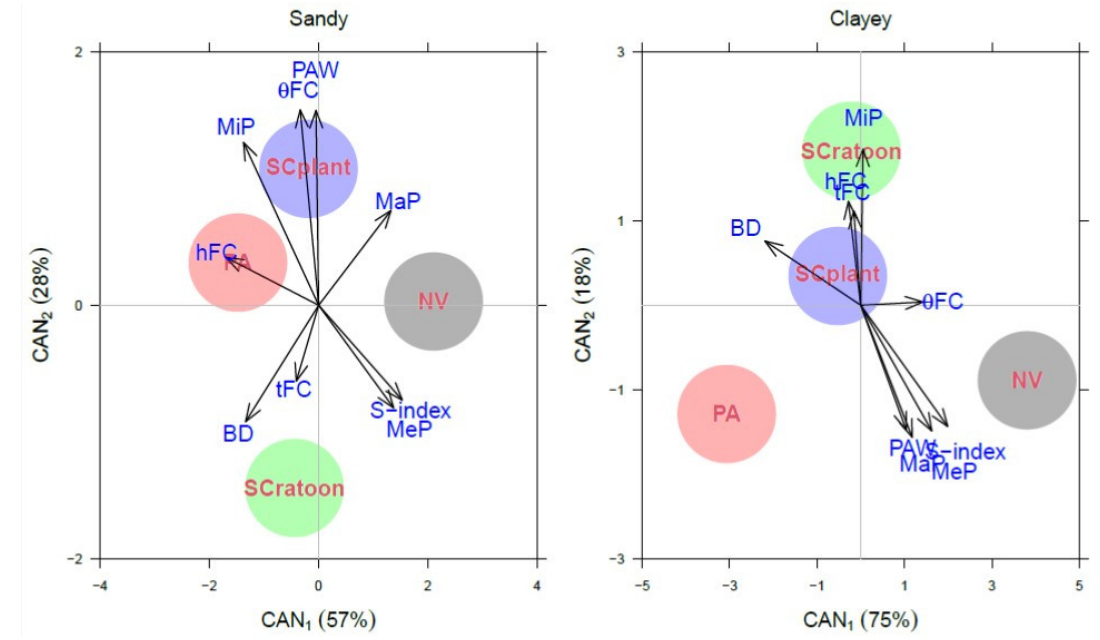
Figure 6. Dispersion of the canonical scores associated with soil porosity (MaP = macroporosity, MeP = mesoporosity, MiP = microporosity), bulk density (BD), parameters from soil water retention curve (θFC = soil water content at field capacity, hFC = water tension at field capacity, tFC = drainage time to reach the field capacity, PAW = plant-available water content, S-index) in four land uses: (NV= native vegetation, PA = pasture, SCplant = sugarcane plant, SCratoon = sugarcane ratoon). n = 48.